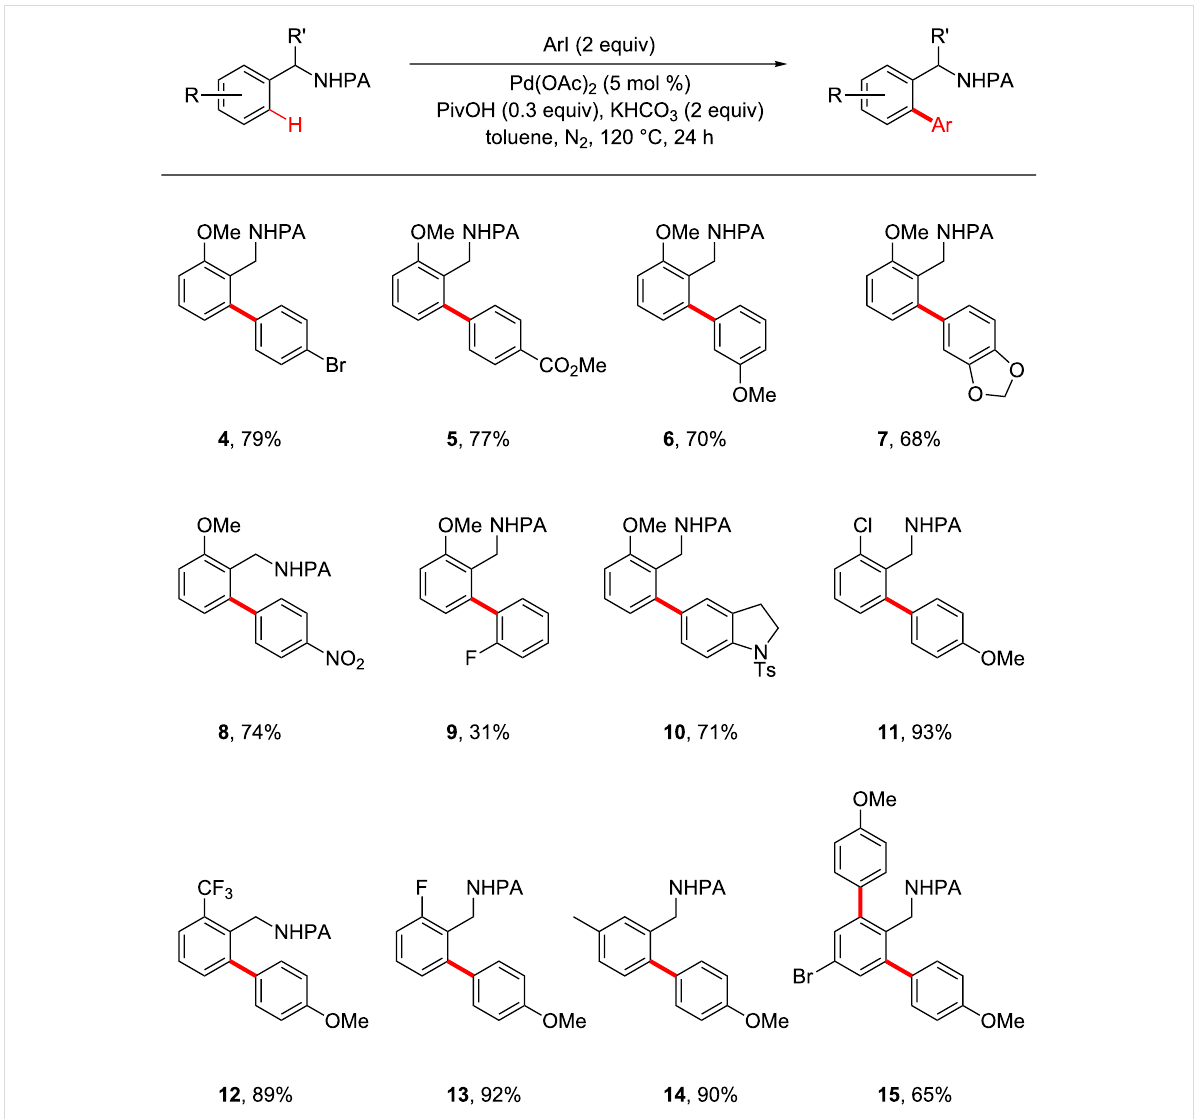
Figure 1: Substrate scope of the Pd-catalyzed PA-directed C–H arylation reaction. All reactions were carried out in a 10 mL glass vial on a 0.2 mmol scale; yields are based on the isolated product.